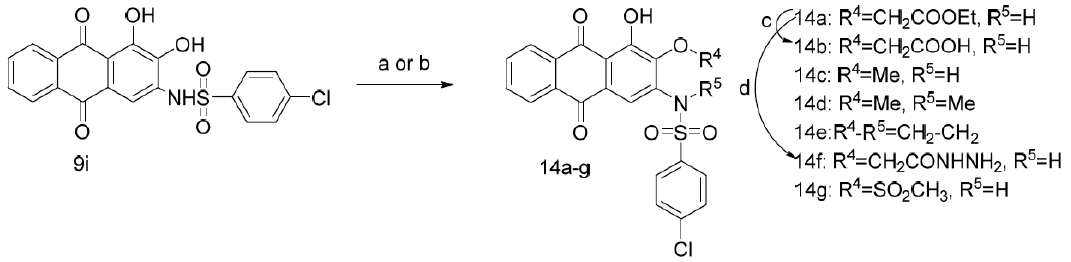
Table 1. Inhibition activity of compounds 6a – e towards PGAM1 .